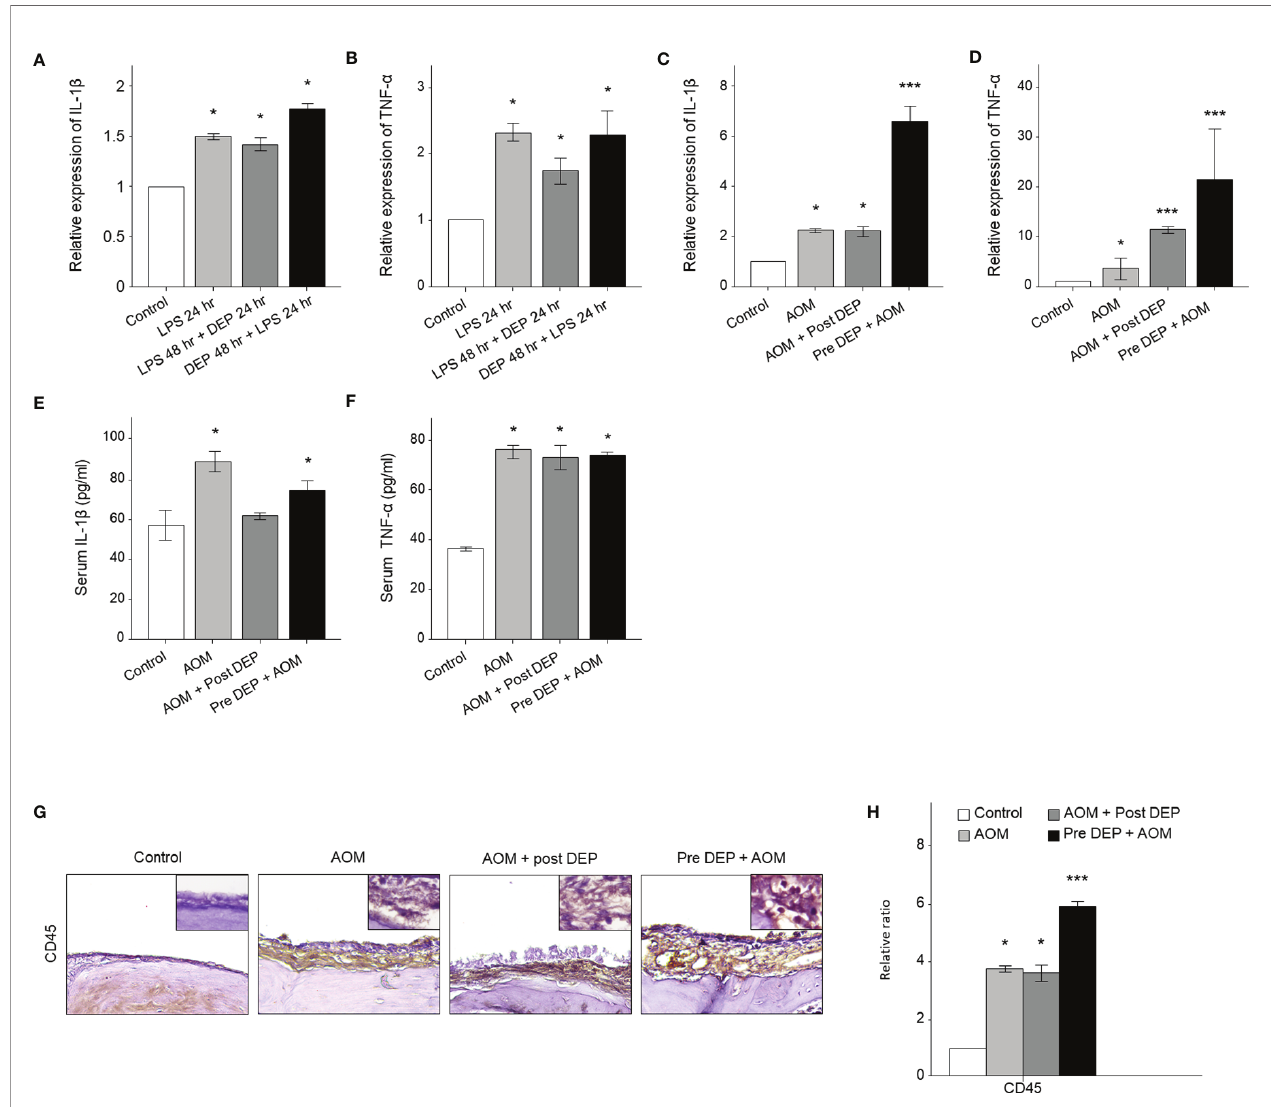
FIGURE 4 | Analysis of cytokine expression in LPS + DEP-exposed mice and HMEECs. The qRT-PCR analysis of mRNA levels of (A) IL-1 b and (B) TNF- a in LPS in HMEECs. The mRNA levels of (C) IL-1 b and (D) TNF- a a mouse model of acute otitis media. The cytokines in the serum of mice were assessed via ELISA kits, including (E) IL-1 b , (F) TNF- a . (G) Immunohistochemical staining of mouse middle ear tissue using antibodies against CD45 (Microvessel; black arrow, magni fi cation ×400). (H) Quantitation of the CD45 staining intensity. *p < 0.05, compared with the control group; ***p < 0.05 compared to the LPS 24 hr and AOM group. LPS, lipopolysaccharide; DEP, diesel exhaust particles; HMEECs, human middle ear epithelial cells; AOM, acute otitis